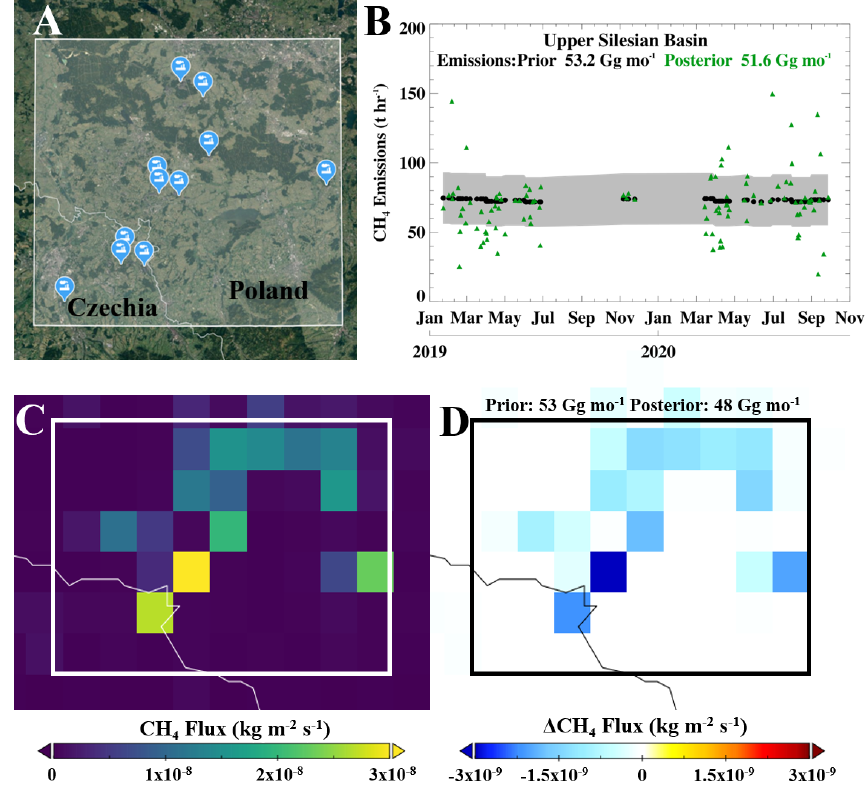
Figure 8. (a) The Upper Silesian Coal Basin 1 ◦ × 0 . 5 ◦ domain indicated by the white box, centred around 50.0 ◦ N, 18.7 ◦ E. Also shown are 11 major coal mines in the region (© Google Maps, 2021). (b) Time series of total prior (black circles) and posterior (green triangles) CH 4 emission estimates within the domain for 2019–2020, where observations and inverse simulations were available. The shaded error denotes prior uncertainty. (c) Prior total CH 4 emissions for 6 June 2018. (d) Average posterior minus prior CH 4 emissions for 6 June